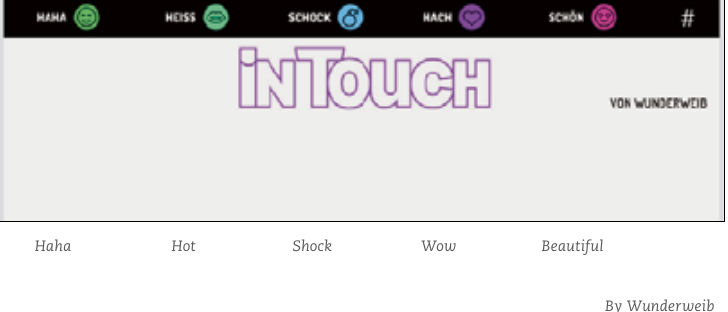
Figure 9 (top). Simplifying tendencies can be found in navigation elements. The website of the lifestyle magazine InTouch (intouch.wunderweib.de) (publishing house: Bauer People Magazin KG, circulation approx. 170,000 in Germany 3/2017) converts navigation nomenclatures into emotions.